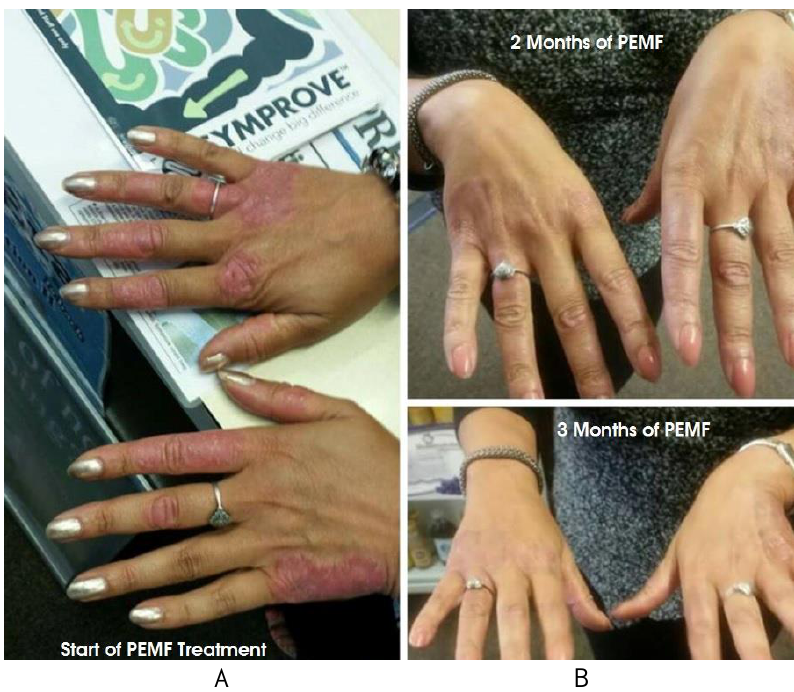
A B Figure 6. The hands' conditions before and after using the Magnapulse on an 8Hz